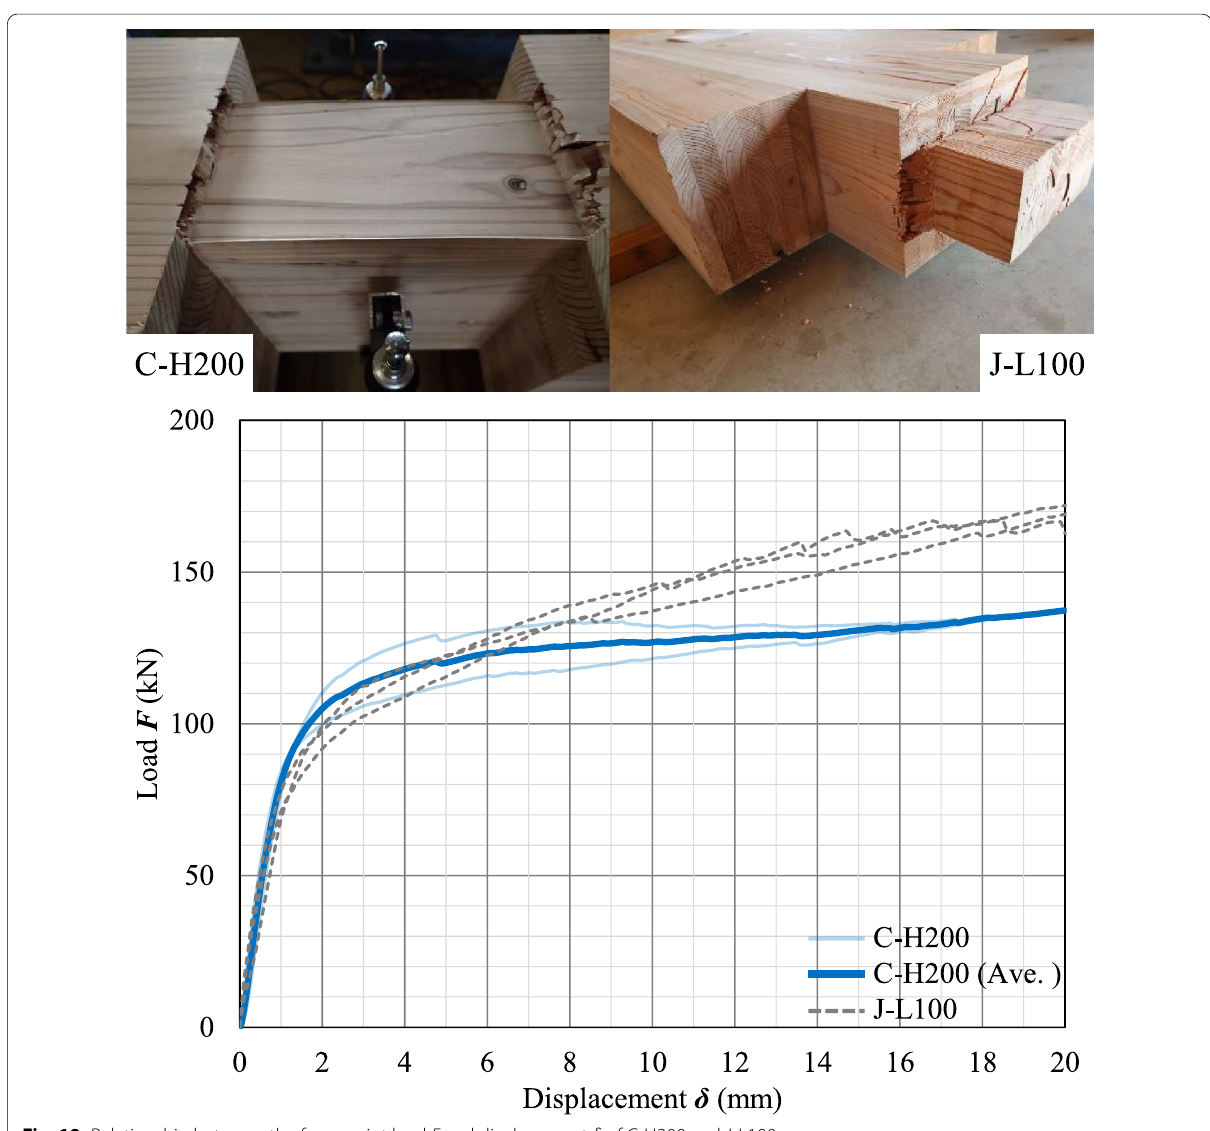
Fig. 19 Relationship between the force point load F and displacement δ of C-H200 and